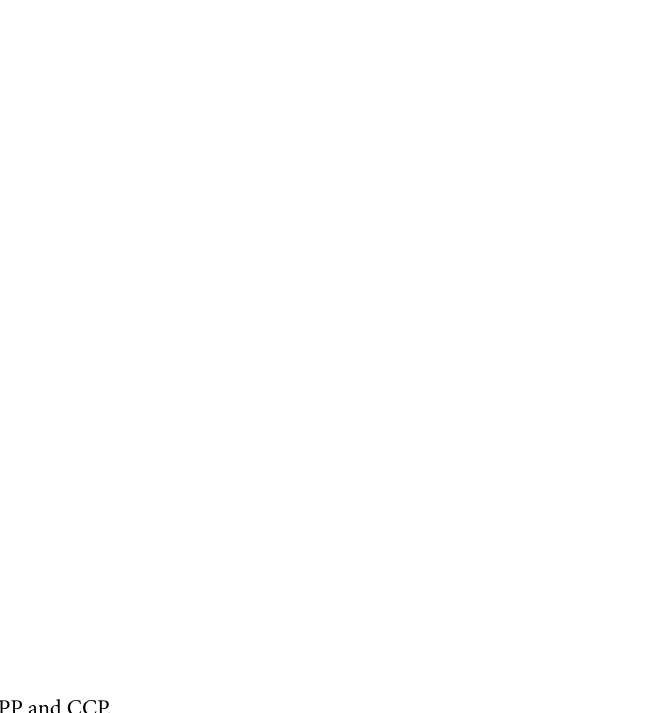
Table 4. Chemical composition of PP and